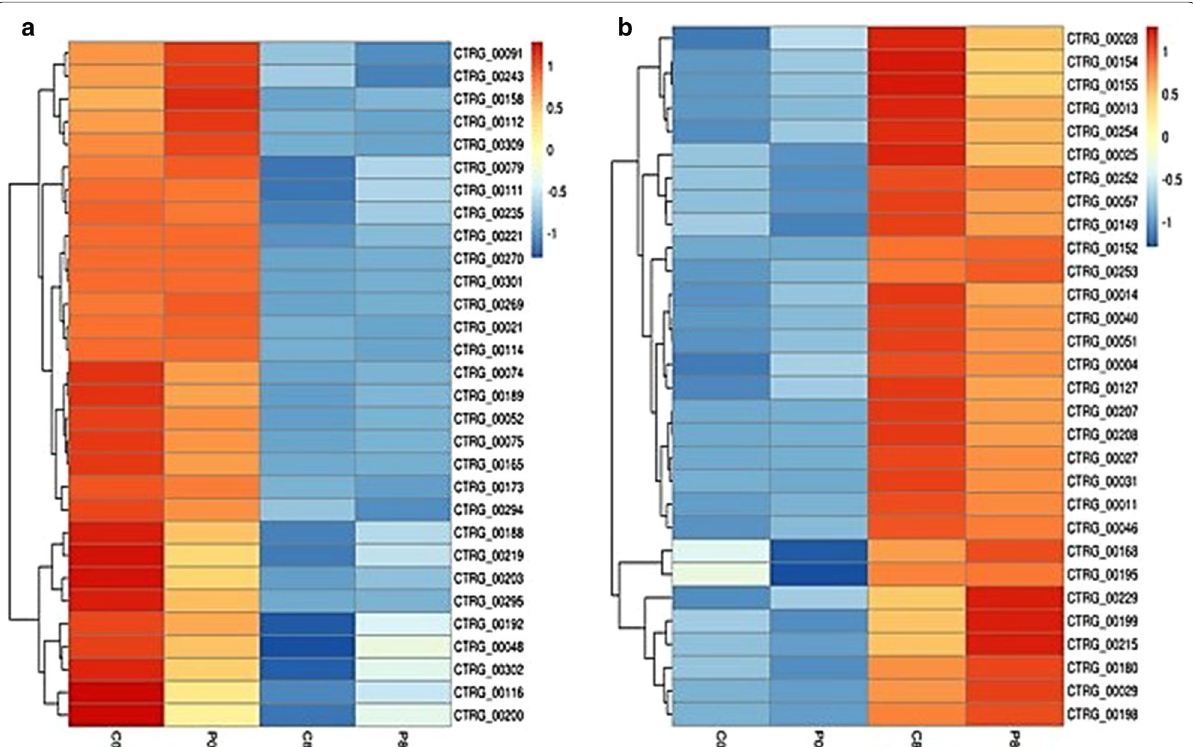
Fig. 1 Heatmap of the top 30 differently expressed genes of contaminant yeast, C. tropicalis at 0 h and 8 h in the fermentation alcoholic cycle. a Down‑regulated genes at 8 h (C8 and P8) in contrast to 0 h (C0 and P0); b up‑regulated genes at 8 h (C8 and P8) in contrast to 0 h (C0 and P0). Genes with log2 Fold Change > 1 or < 1 and FDR < 0.01 with statistical significance. Heatmap values are rlog‑normalized and scale by z‑score. − Color scale ate top right represent lowest to highest change in expression (blue and